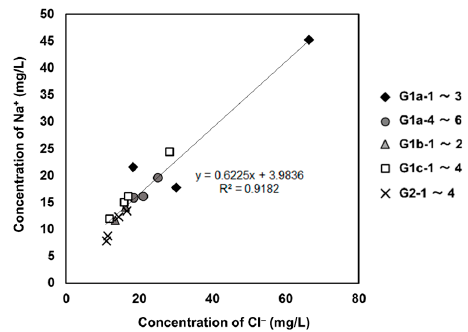
Figure 4. Relationship between concentrations of Cl − and Na + at sampling points along the Galing River.